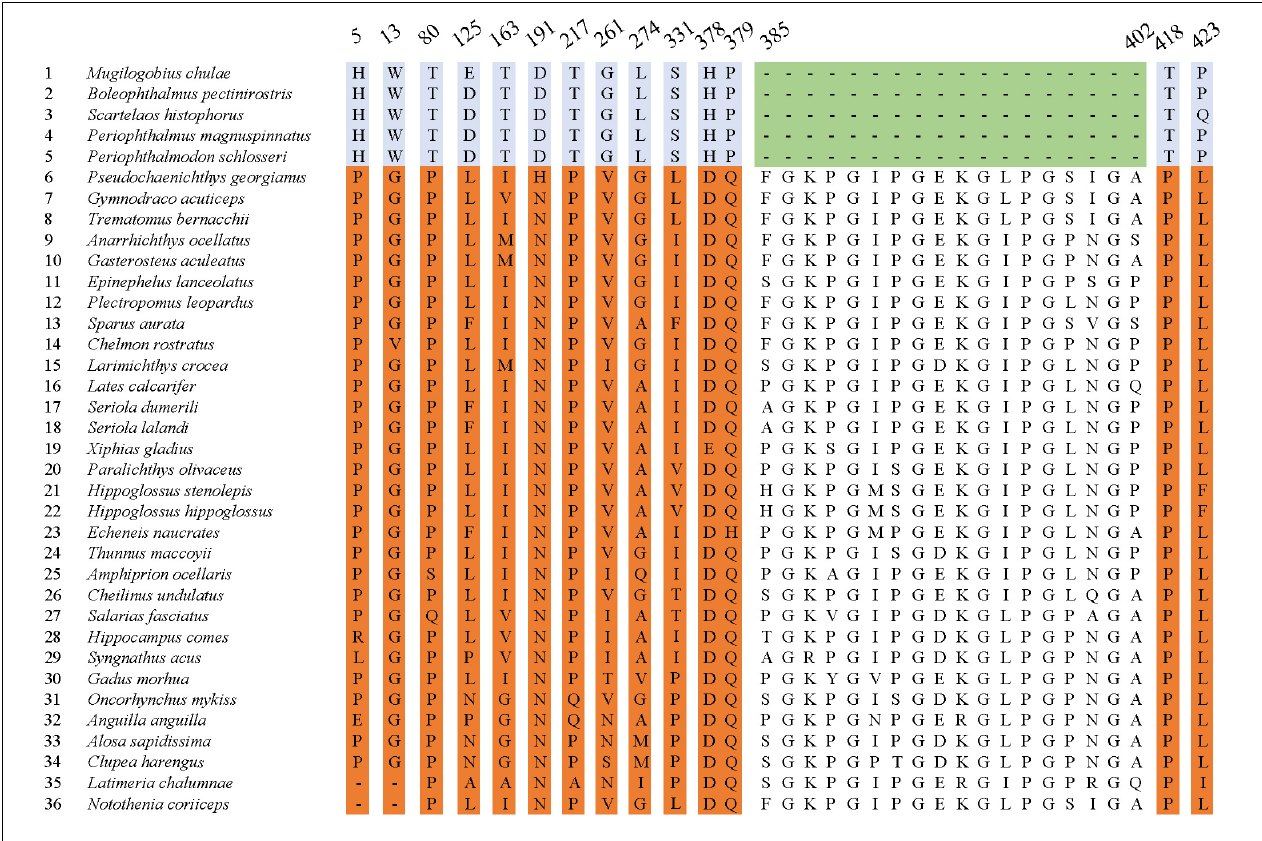
FIGURE 9 | Specific amino acid site substitutions compared with other